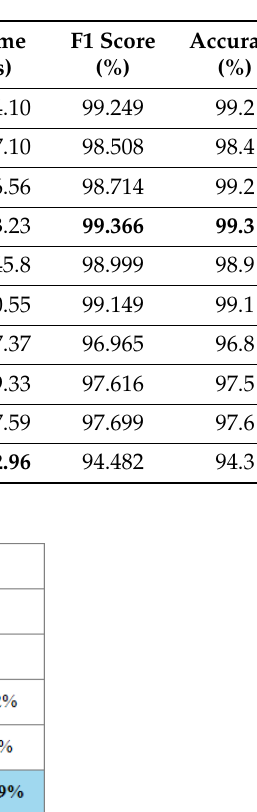
Table 3. Achieved results on KTH dataset after fusion of deep features using SbE approach. The bold represents the best obtained values.